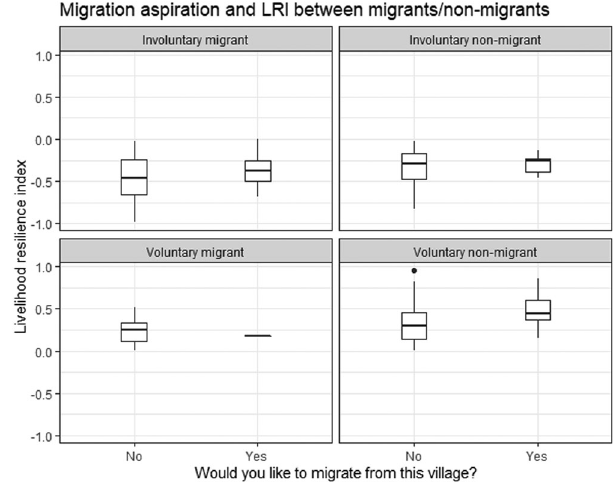
Fig. 5 Livelihood resilience index across types of migration/non- migration. Source: Author ’ s illustration fi eld